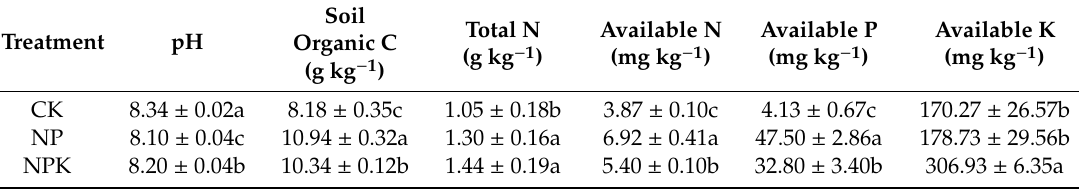
Table 2. Soil pH and nutrient concentrations after long-term fertilization (CK, no fertilizer; NP, nitrogen and phosphorous fertilizer; NPK, nitrogen, phosphorus, and potassium fertilizer). Data are presented as the mean ± standard error ( n = 3). Di ff erent letters indicate significant di ff erences among fertilizer treatments ( p <